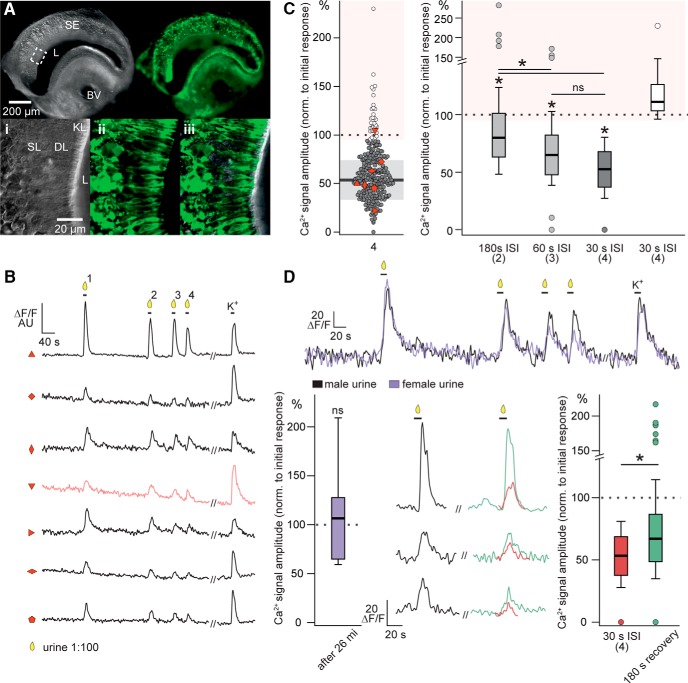

The majority of mouse VSNs display sensory adaptation on repeated stimulation with diluted urine. A, Loading of sensory neurons in acute VNO slices with a synthetic Ca2+ indicator. Top, Low-magnification DIC (left) and epi-fluorescence image (right) of a VNO section bulk-loaded with Cal-520/AM. Bottom, High-magnification images of a region of the sensory epithelium (white box in top image). Confocal DIC (left) and fluorescence (middle) images are merged (right) to show dye loading of sensory neurons. B, Representative original recordings of cytosolic Ca2+ signals in different VSN somata in response to diluted urine (1:100; 10 s) and elevated extracellular potassium (K+; 50 mM; 10 s). The integrated relative fluorescence intensities (ΔF/F) in user-defined ROIs are displayed in arbitrary units and viewed as a function of time. Neurons are stimulated at decreasing ISI of 180 s (1 → 2), 60 s (2 → 3), and 30 s (3 → 4). Black traces represent VSNs that undergo sensory adaptation of variable degree. Red trace shows a neuron that displays no adaptation. C, left, Scatter dot plot depicting relative Ca2+ signal amplitudes recorded from a total of 259 VSNs in response to stimulation 4 [data points show signal strength as percentage of the initial response amplitude (1)]. Data are categorized as indicative of adaptation (<95%; gray; n = 227) or the lack thereof (≥95%; white; n = 32). Data points marked by different red symbols correspond to original recordings shown in B. Solid horizontal line and gray shadow indicate mean ± SD of adapting VSNs. Right, Box plots illustrating the Ca2+ signal amplitudes evoked by stimulations 2 (180 s ISI), 3 (60 s ISI), and 4 (30 s ISI). Data are shown as percentage of the response to initial stimulation (1). Median values (horizontal lines), the interquartile ranges (height of the box), and the minimum and maximum values (whiskers) are plotted. Circles depict values that were >1.5 times the interquartile range from the lower or upper quartile. White box (right) corresponds to the VSNs categorized as not adapting. D, top, Original recording from a representative VSN consecutively challenged with male (black trace) and female (purple trace) urine. Interval between recordings 26 min. Fluorescence intensity (ΔF/F) is plotted as a function of time. Stimulation paradigm as in B. Bottom, Box plot (left; n = 27) quantifying and comparing the Ca2+ signal amplitudes evoked by the initial stimulations with diluted male and female urine, respectively. Note that sensitivity is fully restored after 26 min. Middle/right, Original traces and box plot quantification illustrating initial responses (black traces), responses to stimulation 4 (30 s ISI; red traces and box), and responses to a fifth stimulation after an additional 180 s recovery period (green traces and box). Asterisk (*) indicates statistical significance, p < 0.01 (one-way ANOVA in C; paired t-test in D). BV, blood vessel; DL, dendritic layer; KL, knob layer; L, lumen; SE, sensory epithelium; SL, soma layer; VNO, vomeronasal organ.